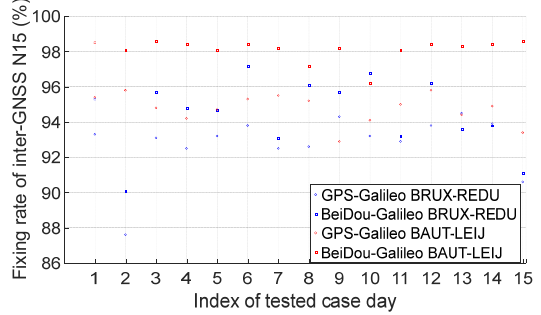
Figure 19. Fixing rate of the inter ‐ GNSS wide lane N15.